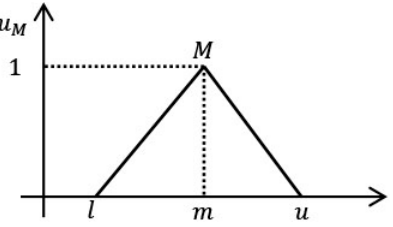
Figure 4. Triangular fuzzy number M = [ l , m , u ] and its relational function.